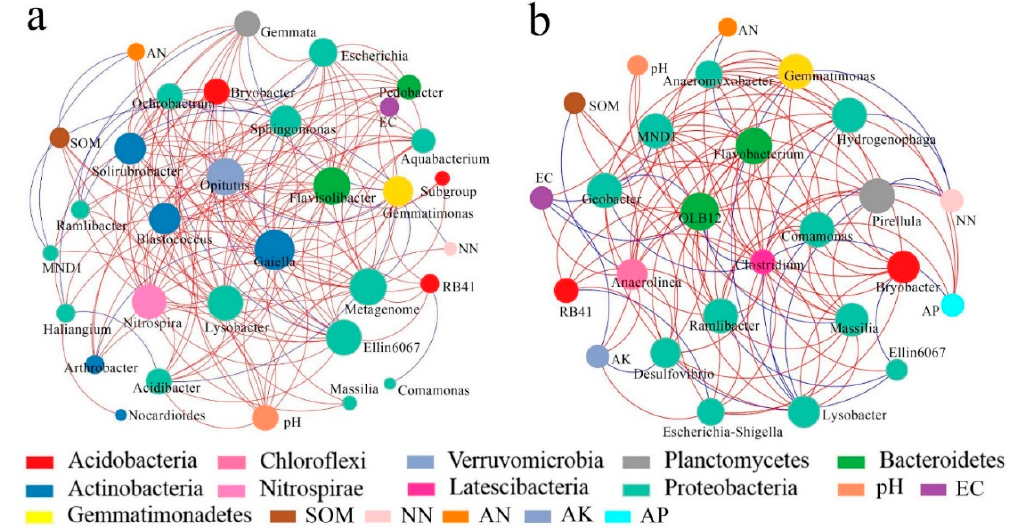
Figure 9. Molecular ecological networks of dominant bacterial species and environmental factors in DL ( a ) and PF ( b ).